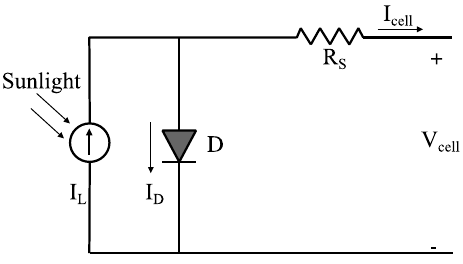
Figure 2. Single-Diode model of a photovoltaic cell, showing the added lumped series resistor (cid:1844) (cid:2929)